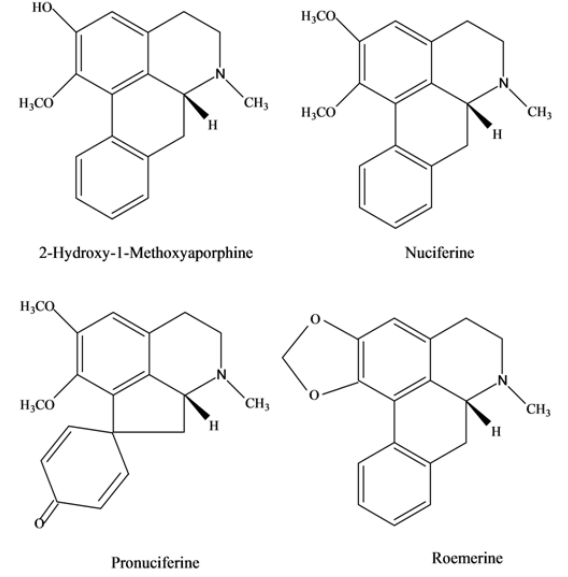
Figure 1. Structural formulas of aporphine alkaloids from leaves of N . nucifera .